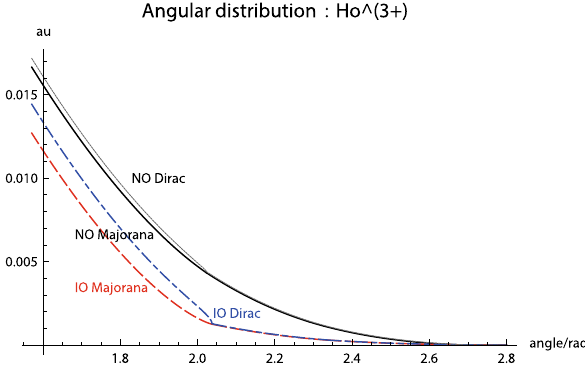
Fig. 7 RANP angular distribution with r = − 0 . 36532 of trivalent Ho.